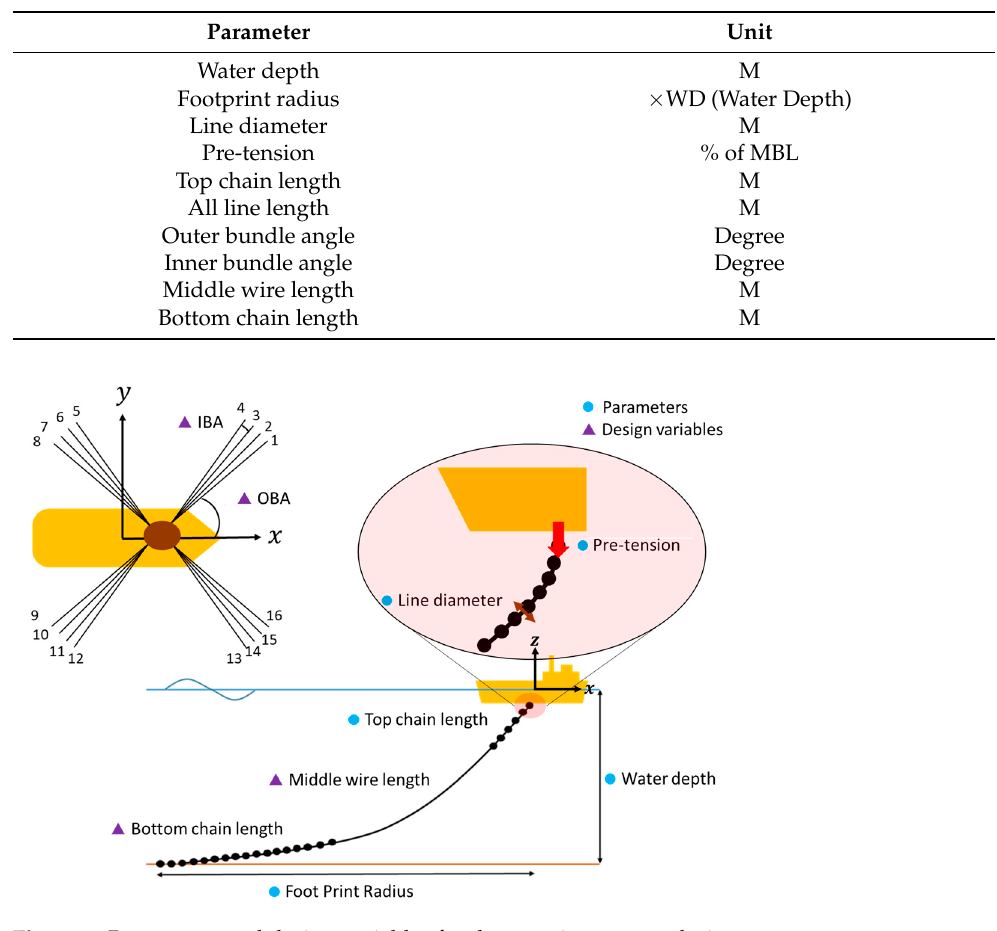
Figure 1. Parameters and design variables for the mooring system